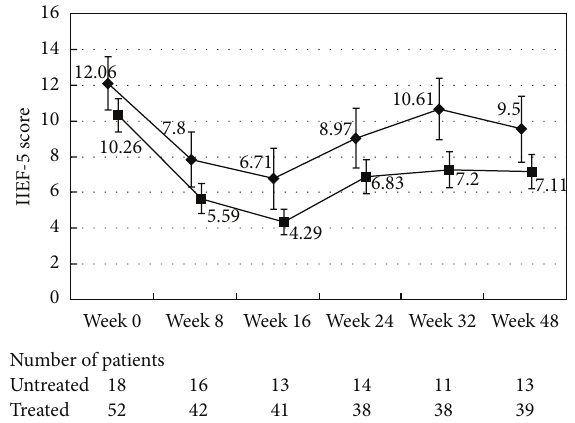
Figure 5: International Index of Erectile Function-5 score. The scores in the patients treated with an 𝛼 1-blocker or anticholinergic agent ( ◼ ) and the untreated patients ( ⧫ ) are shown. The values are LS mean ± SE. 𝑃 = 0.6575 (repeated ANOVA).